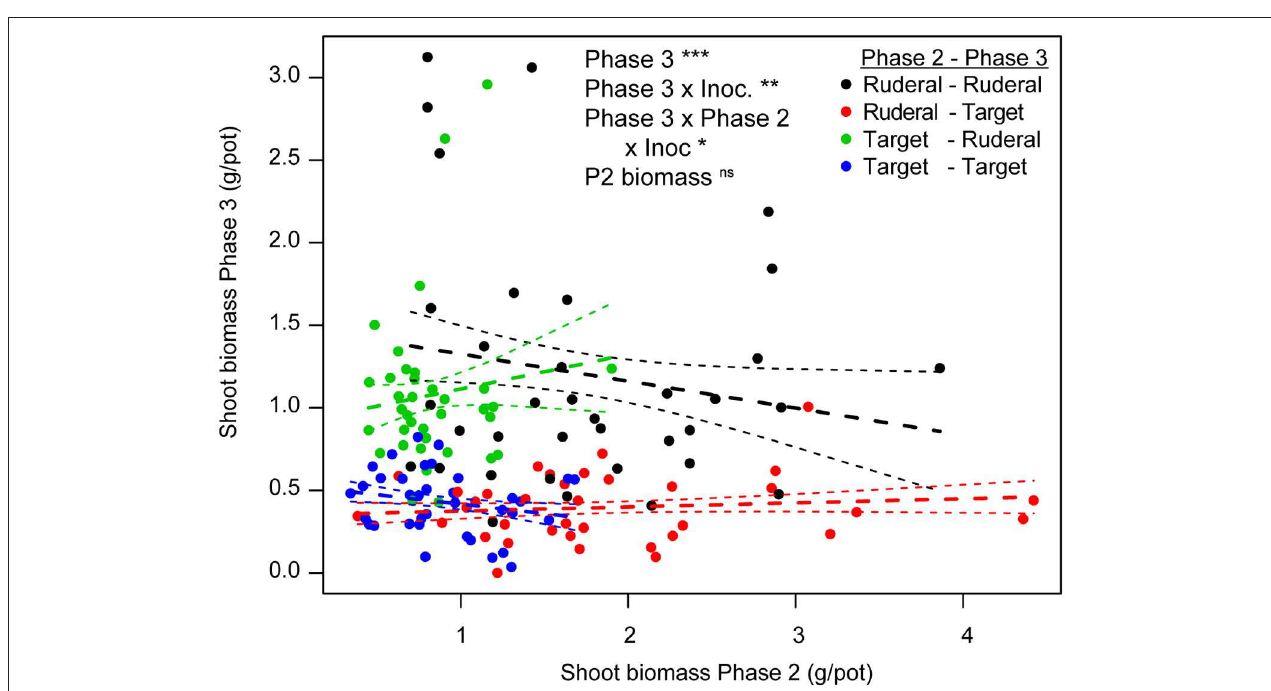
FIGURE 3 | Relationship between shoot biomass per pot in Phase 3 and Phase 2 for each of the four species groups. Significant effects in the mixed model with Phase 2 biomass as a covariate are indicated using stars (* p < 0.05, ** p < 0.025, *** p < 0.001), for statistical analysis see Table S4 . As a visual aid the fitted relationship of simple linear regressions per feedback group are given as dashed lines (mean ± SE). These analyses show that the effect of Phase 2 biomass was non-significant in all feedback groups.